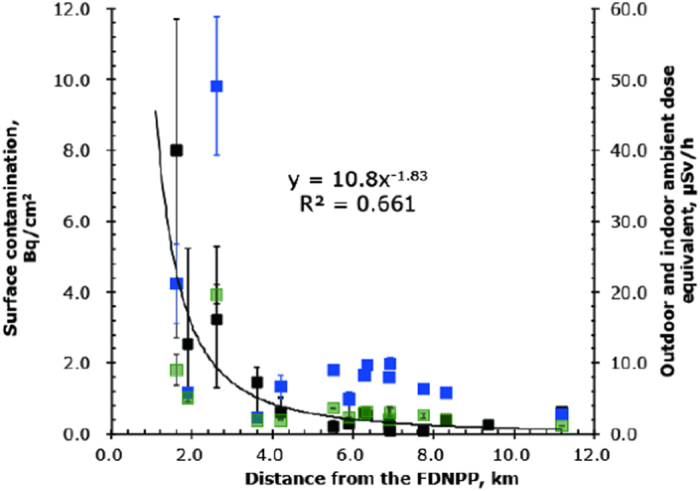
Median surface contamination (black closed square), with an interquartile range of Q1–Q3 for each residential house in Okuma, Futaba, and Tomioka, plotted as a function of distance between each house and the FDNPP.The average outdoor and indoor ambient dose equivalents obtained for each house are also shown in the figure as blue and green squares, respectively with one standard deviation. The measurements obtained from a house in Okuma, where the decontamination work was completed, were excluded from this figure.